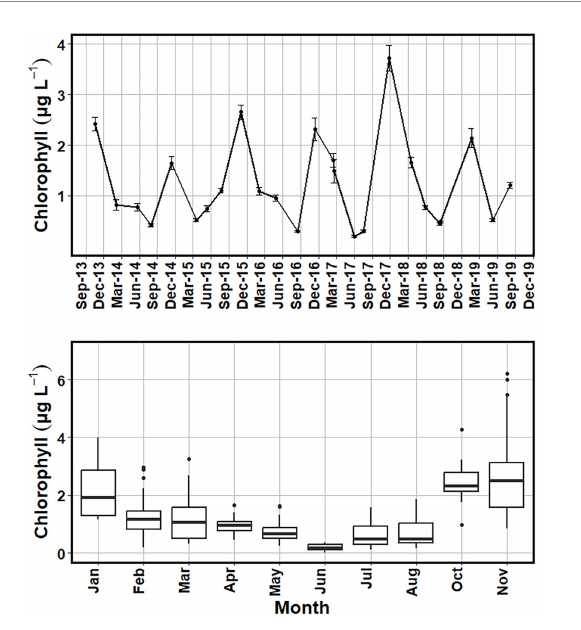
FIGURE 9 Average surface chlorophyll ( μ g L − 1 ) (top) with error bars of one standard error added to show the variance of the values. Boxplots of surface chlorophyll ( μ g L − 1 ) (bottom) showing the range of chlorophyll values obtained for sampling dates within each month from October 2013 to August 2019.